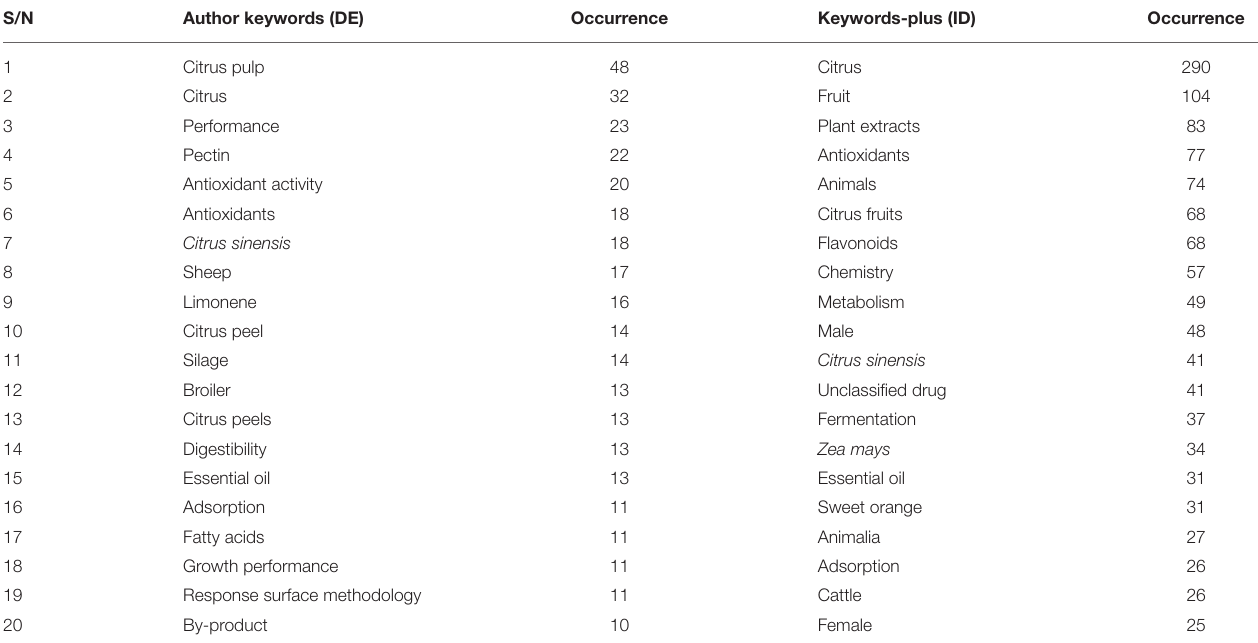
TABLE 4 | Most relevant words used by researchers in the field of citrus waste and animal feed production.